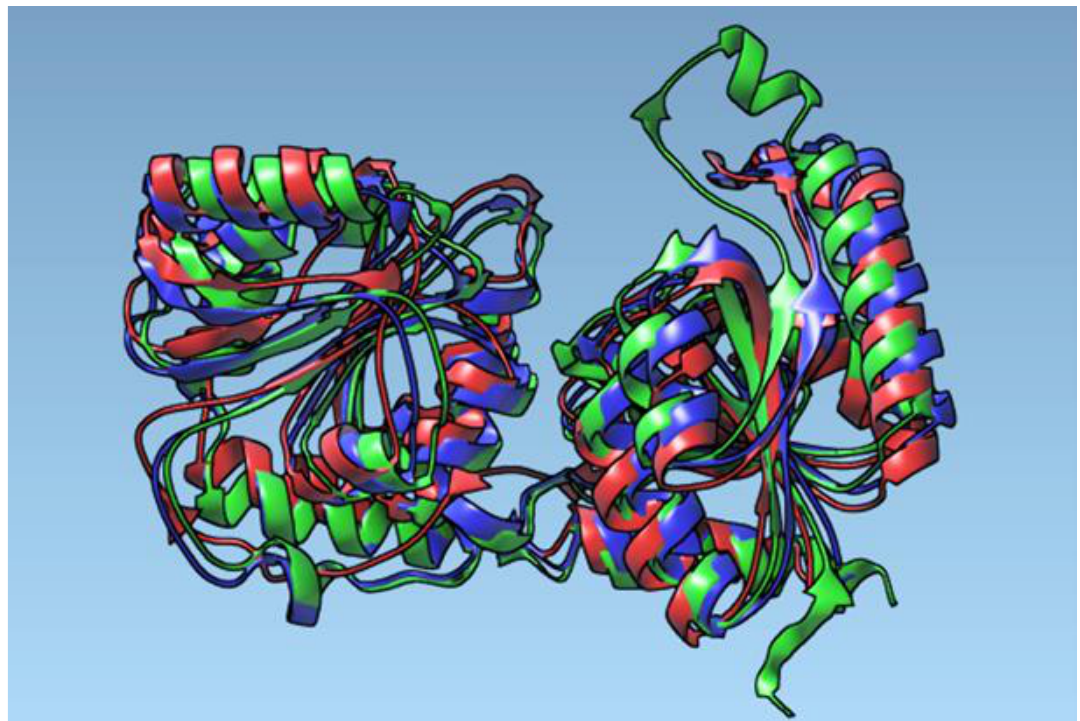
Figure 8. Comparison between the PBD: 1NLM and new model. Aligned models using green—predicted structure with ESMFold (implemented in SAMSON); red—Swiss model server and blue—PDB: 1NLM.